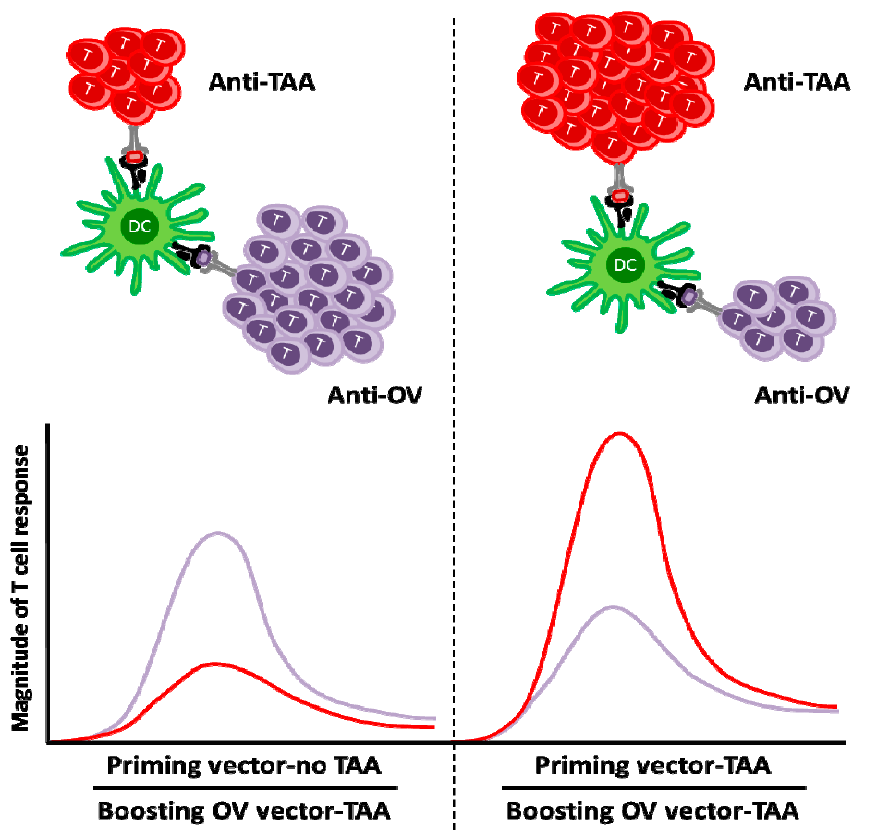
Figure 2. Left side: Enhanced anti-tumor response when using OV to boost a TAA prime. When boosting an anti-TAA response with an OV, two distinct viral vectors encoding a common tumor-associated antigen are employed. Priming with an empty adenoviral vector (Priming vector-no TAA) and boosting with a rhabdovirus expressing a TAA (Boosting OV vector-TAA) induces an anti-TAA response which is overshadowed by the anti-OV response; Right side: Priming with an adenoviral vector expressing a TAA (Priming vector-TAA) and boosting with a rhabdovirus expressing the same TAA (Boosting OV vector-TAA) induces a dramatically enhanced anti-TAA response and a reduced anti-OV response.